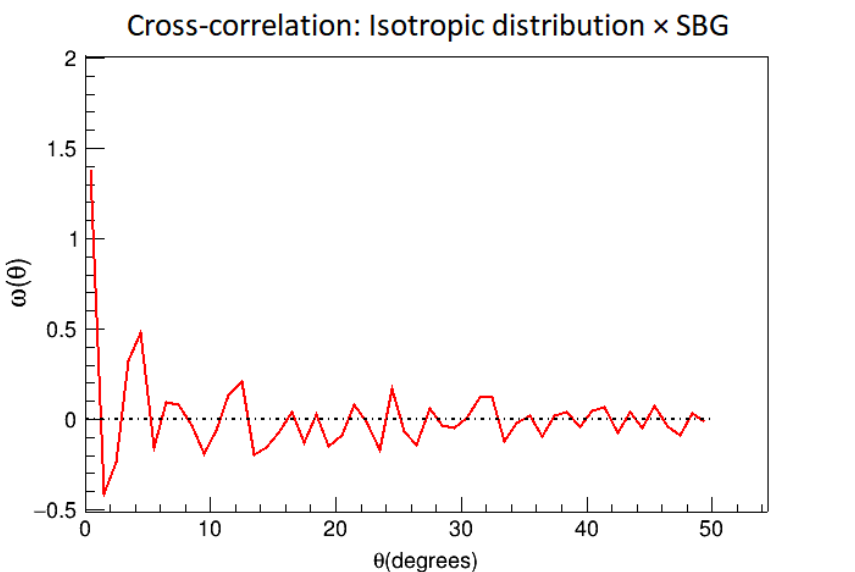
Figure 1. Example of Landy–Szalay cross-correlation estimator between a simulated isotropic dataset and positions of starburst galaxies. The red line is the value of estimator ω ( θ ) as a function of angular scale θ obtained for the data. The black dotted line shows the expected value in the isotropic